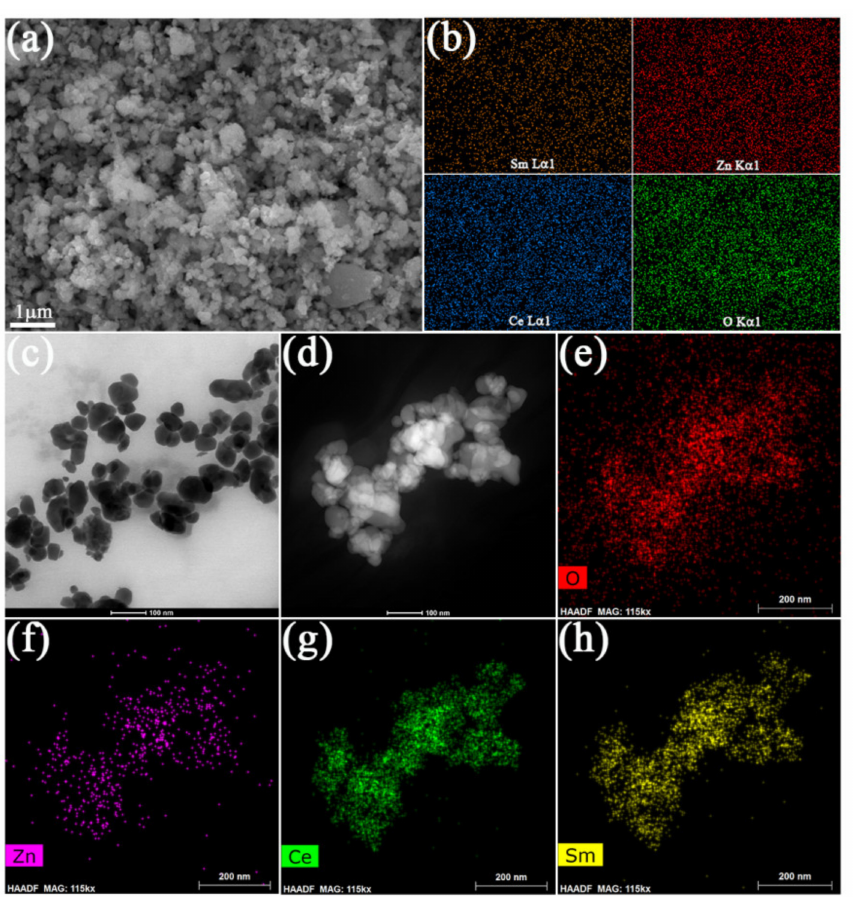
Figure 2. ( a ) SEM image and ( b ) EDS mappings of the 5LZO-5SDC powder; ( c ) bright-field and ( d ) dark-field TEM images of 5LZO-5SDC, and the elemental mappings of ( e ) O, ( f ) Zn, ( g ) Ce, ( h ) Sm based on the dark-field TEM